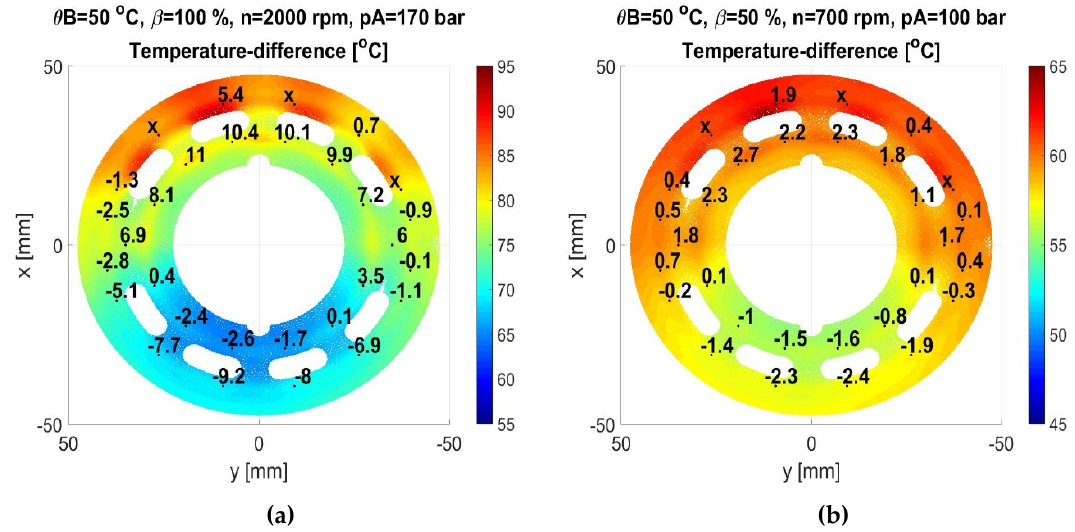
Figure 13. ( a ) Di ff erence between simulation and measurement at high power operating condition; ( b ) di ff erence between simulation and measurement at low power operating condition.